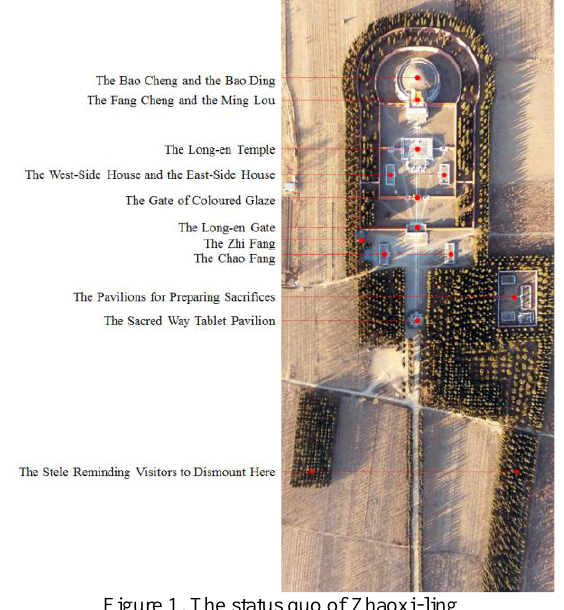
Figure 1. The status quo of Zhaoxi-ling